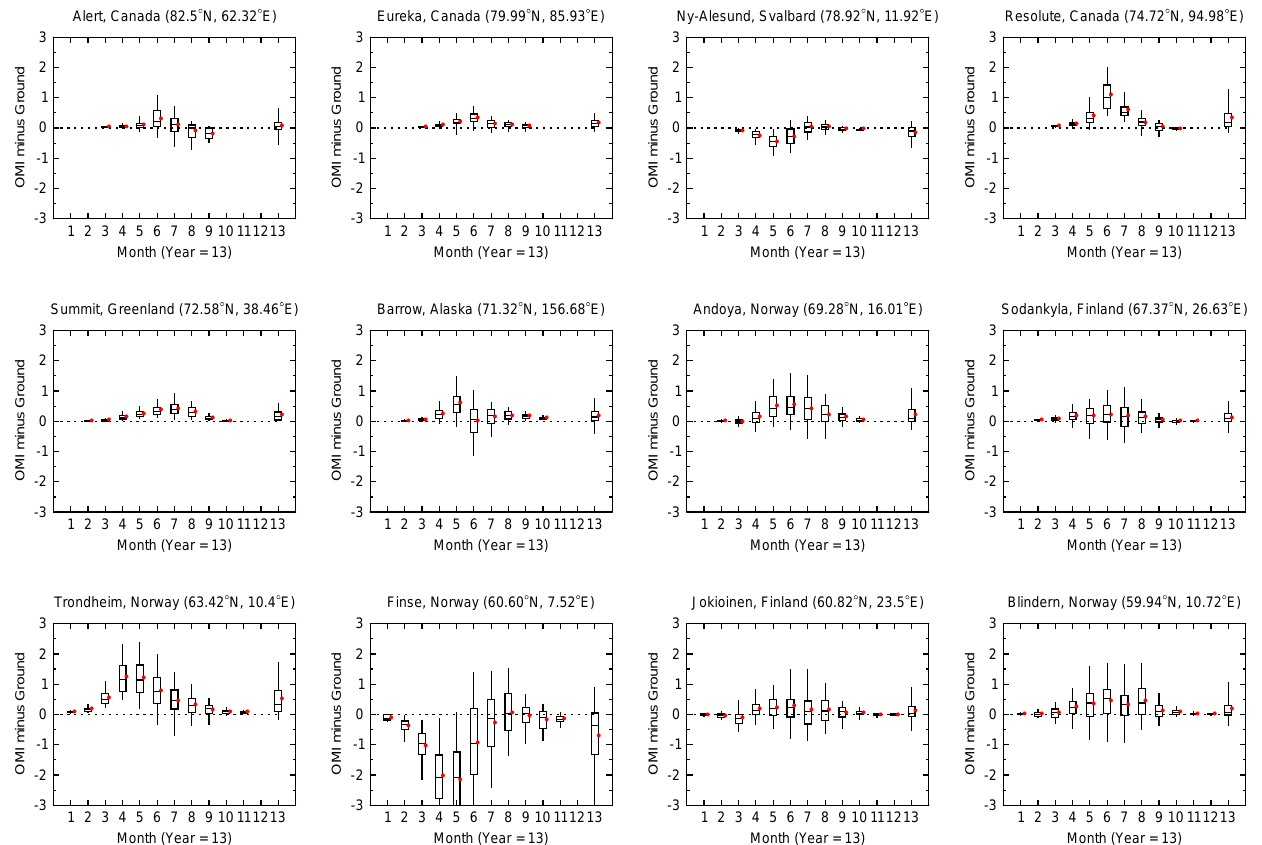
Figure 7. Difference of OMI and ground UVI data, calculated from overpass erythemal dose rate data (DP 1). The box-whisker plots indicate for each month the 5th and 95th percentiles (whisker), the interquartile range (box), median (line), and average (red dot). Statistics based on annual data are indicated as the 13th month. Match-up data were filtered for SZA < 84 ◦ and Dis <